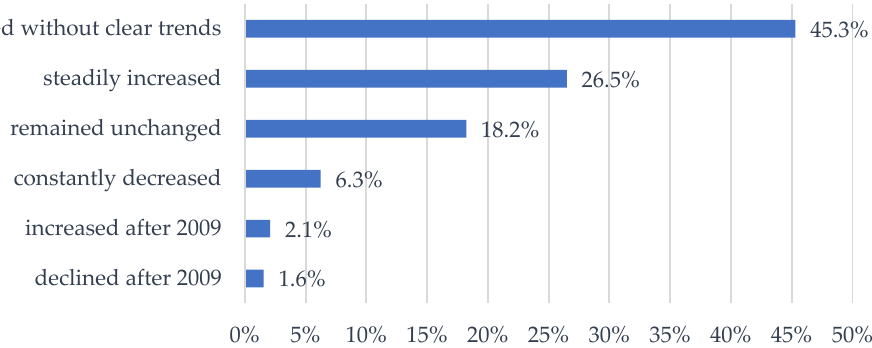
Figure 2. Changes in the level of savings of the surveyed agricultural households in the years 2004–2019 ( n = 191). Source: own study.